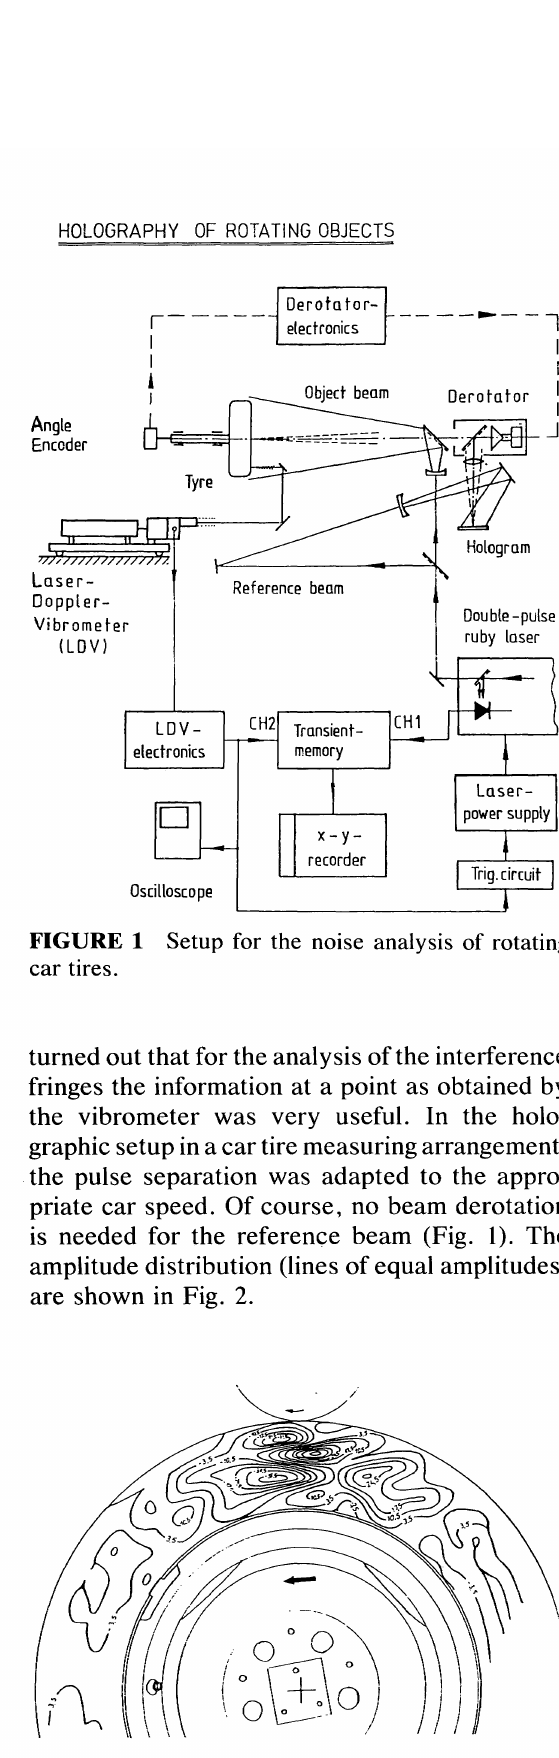
FIGURE 2 Mechanical deformation of a tire with the pulse separation of 40 JLS, showing lines of equal defor